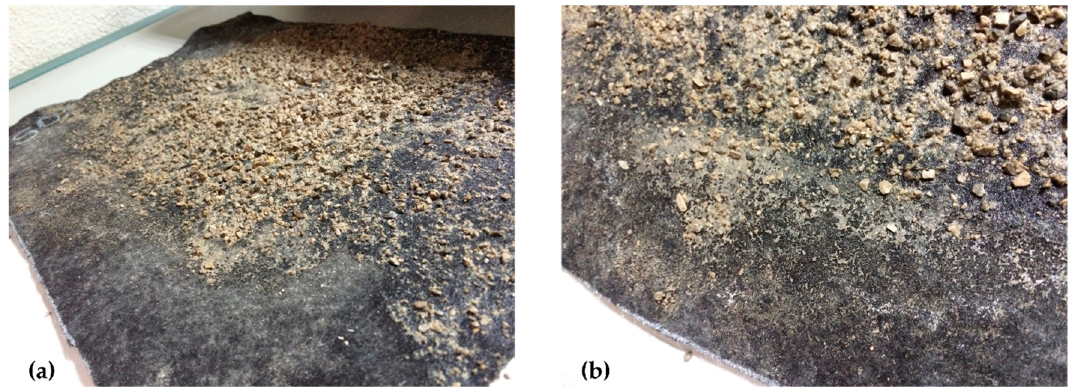
Figure 10. ( a ) Appearance of the geotextile after the hydraulic damage simulation; ( b ) Detail view, where the cementation produced by the passing of water can be observed.